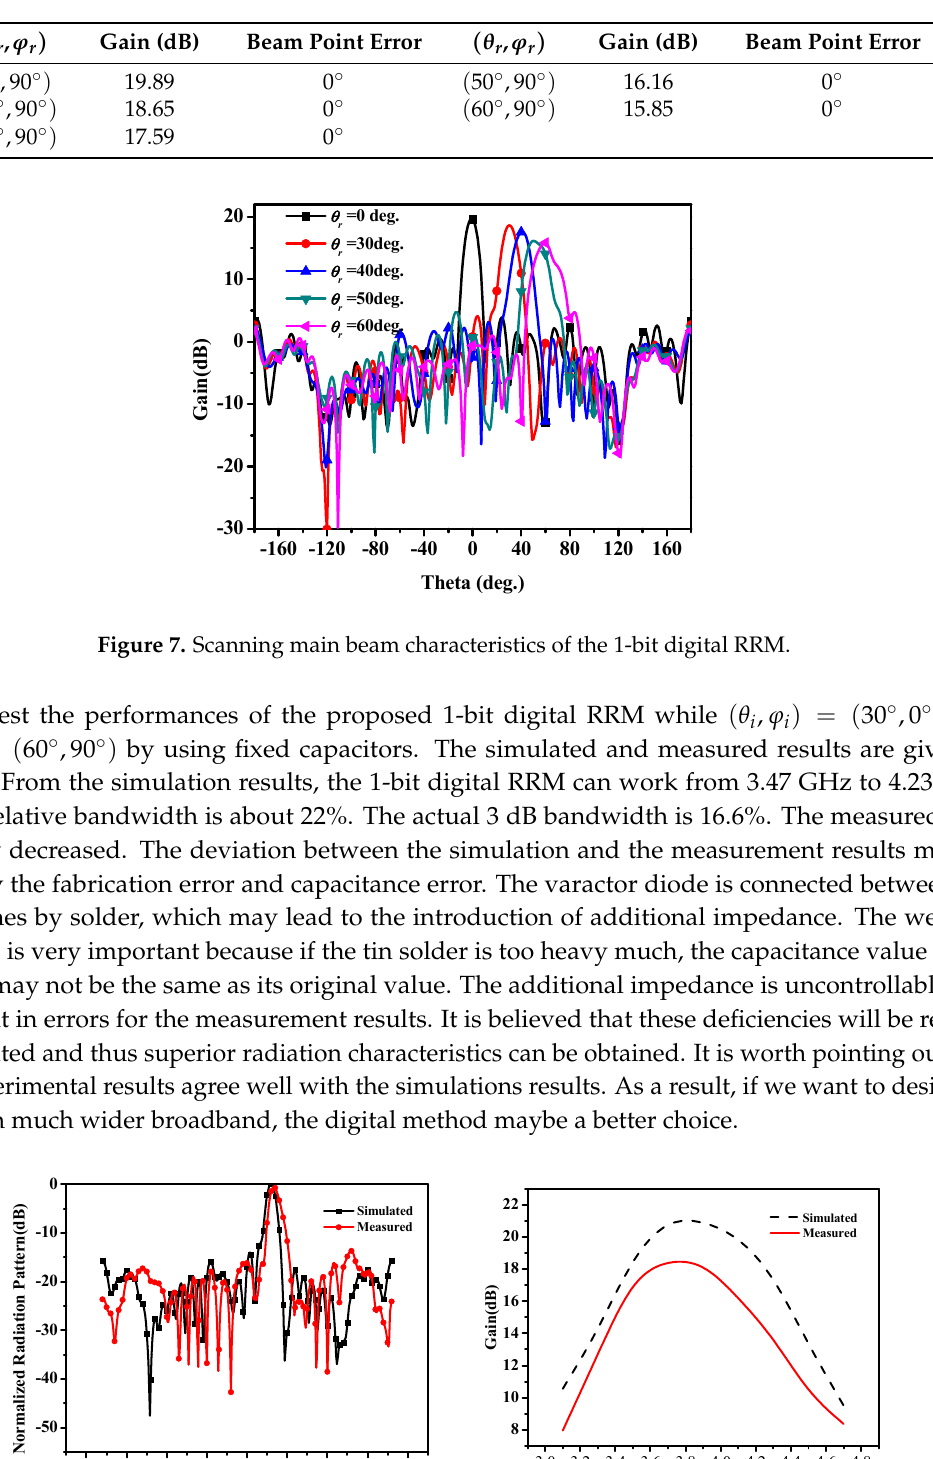
Figure 8. Comparison of measured and simulated results of the fabricated RRM ( a ) Normalized radiation pattern at 3.5 GHz; ( b ) Gain characteristics.